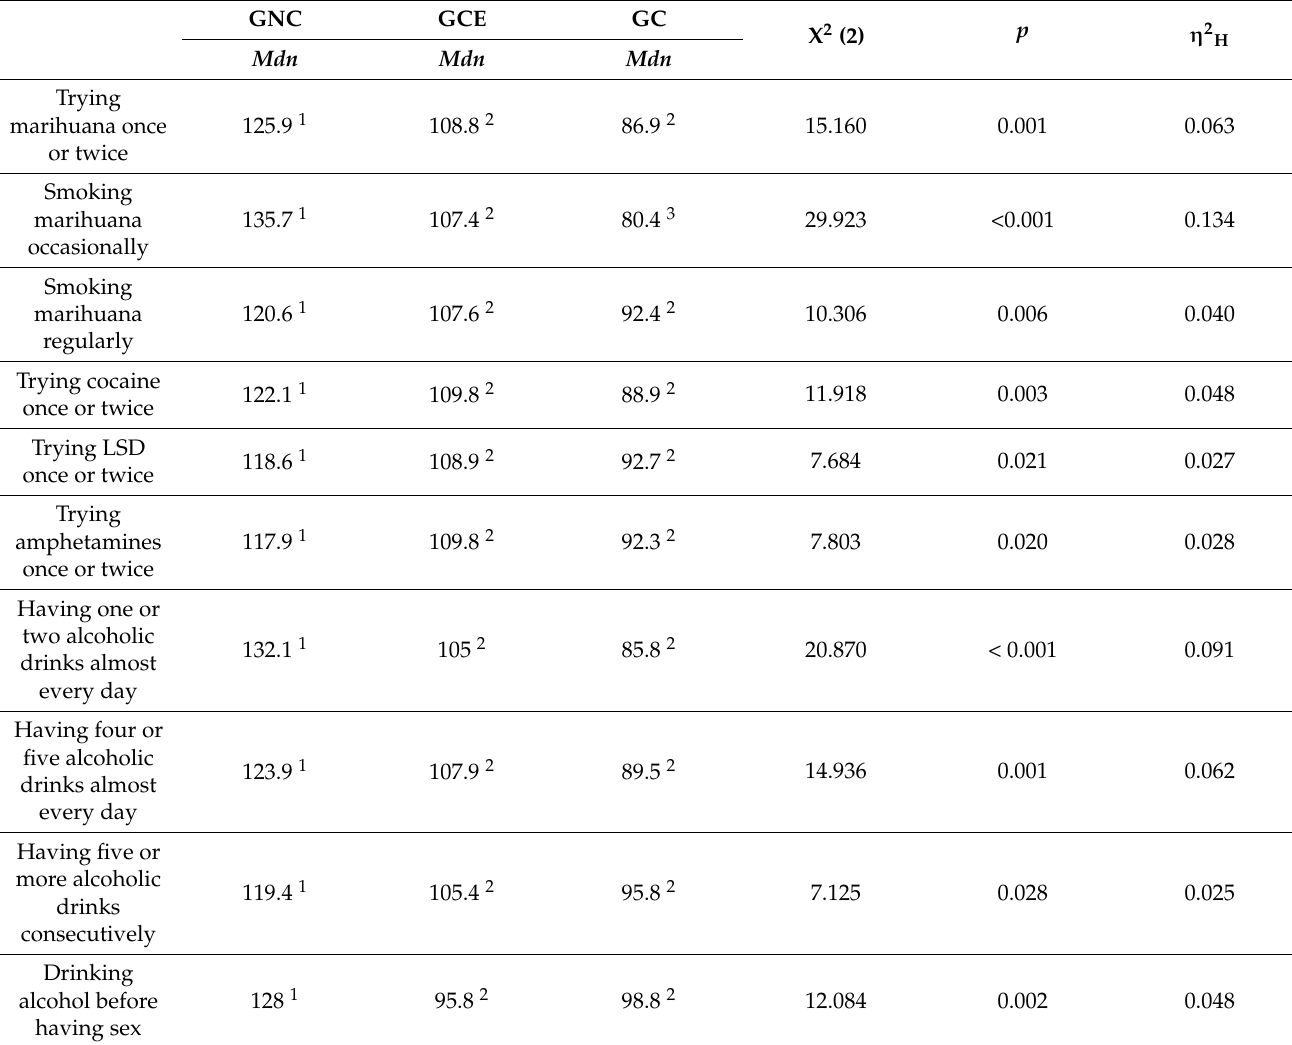
Table 4. Comparison of the risk perception of consuming different substances by